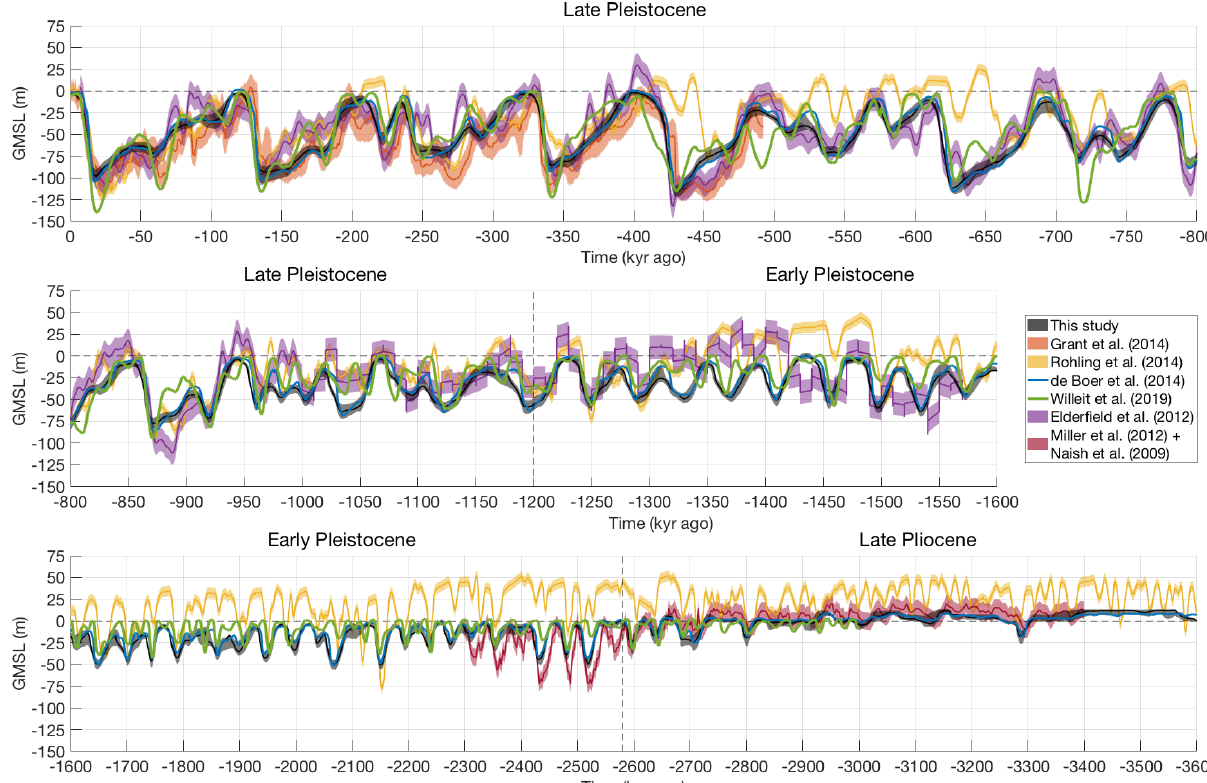
Figure 5. Reconstructed global mean sea level for the entire simulation period (black), compared to reconstructions based on Red Sea δ 18 O (Grant et al., 2014; red); Mediterranean δ 18 O (Rohling et al., 2014; yellow); an ice-sheet-model-based inversion of the global benthic δ 18 O similar to this study (de Boer et al., 2014; blue); an insolation-forced, fully coupled ice-sheet–climate–carbon-cycle model (Willeit et al., 2019; green); a separation of the ice- and temperature-induced δ 18 O signals based on Mg / Ca ratios (Elderfield et al., 2012; purple); and a direct scaling of benthic δ 18 O scaled to match results from geological backstripping (Miller et al., 2012; Naish et al., 2009; dark red). The present-day value of 0 is shown by a dashed line. Table 1. Statistical comparison of the different model-based CO 2 reconstructions (this study; van de Wal et al., 2011; Stap et al., 2017; Willeit et al., 2019) to the EPICA Dome C ice-core record (Bereiter et al., 2015), as well as the glacial–interglacial amplitude in CO 2 both before and after the MPT for the different reconstructions. EPICA Linear regression This study Wal2011 Stap2017 Willeit2019 Optimized time lag (kyr)